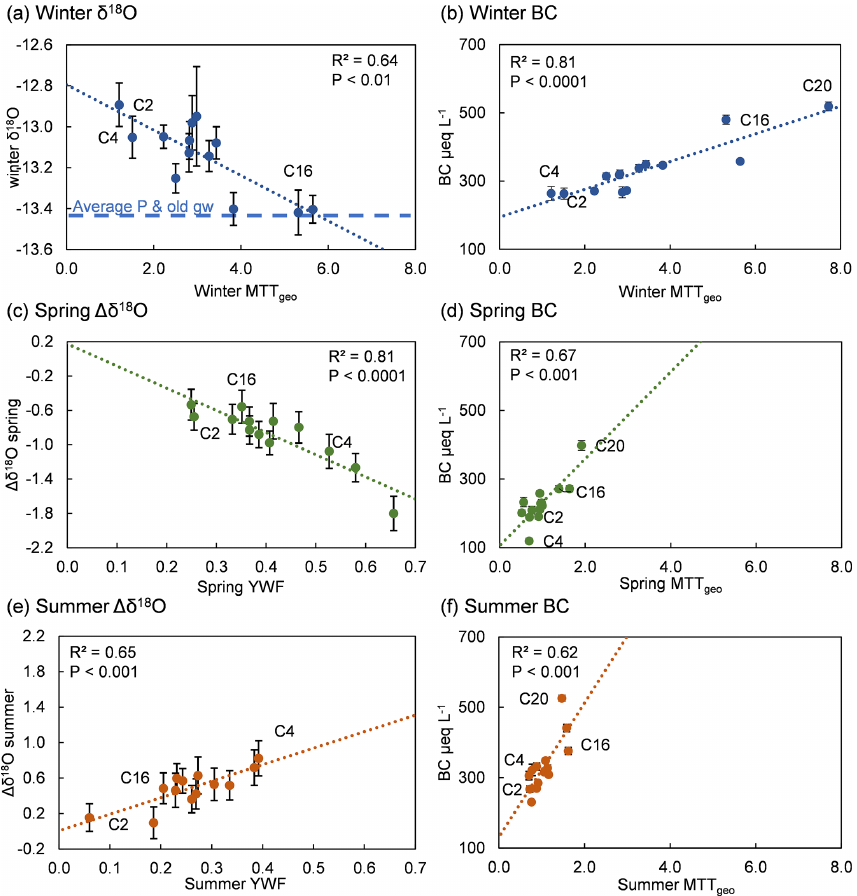
Figure 7. Relationships of seasonal MTT geo and young water fractions (YWFs) with seasonal stream isotopic composition and base cation concentration. Note that δ 18 O results are for 13 sites, while the BC record comprises all 14. The sub-plots (a) to (f) show the δ 18 O (winter) or (cid:49)δ 18 O spring/summer and BC concentrations as a function of the MTT geo in winter, spring, and summer, respectively. The standard error of the mean (SEM) shown as whiskers denotes variations in field observations.